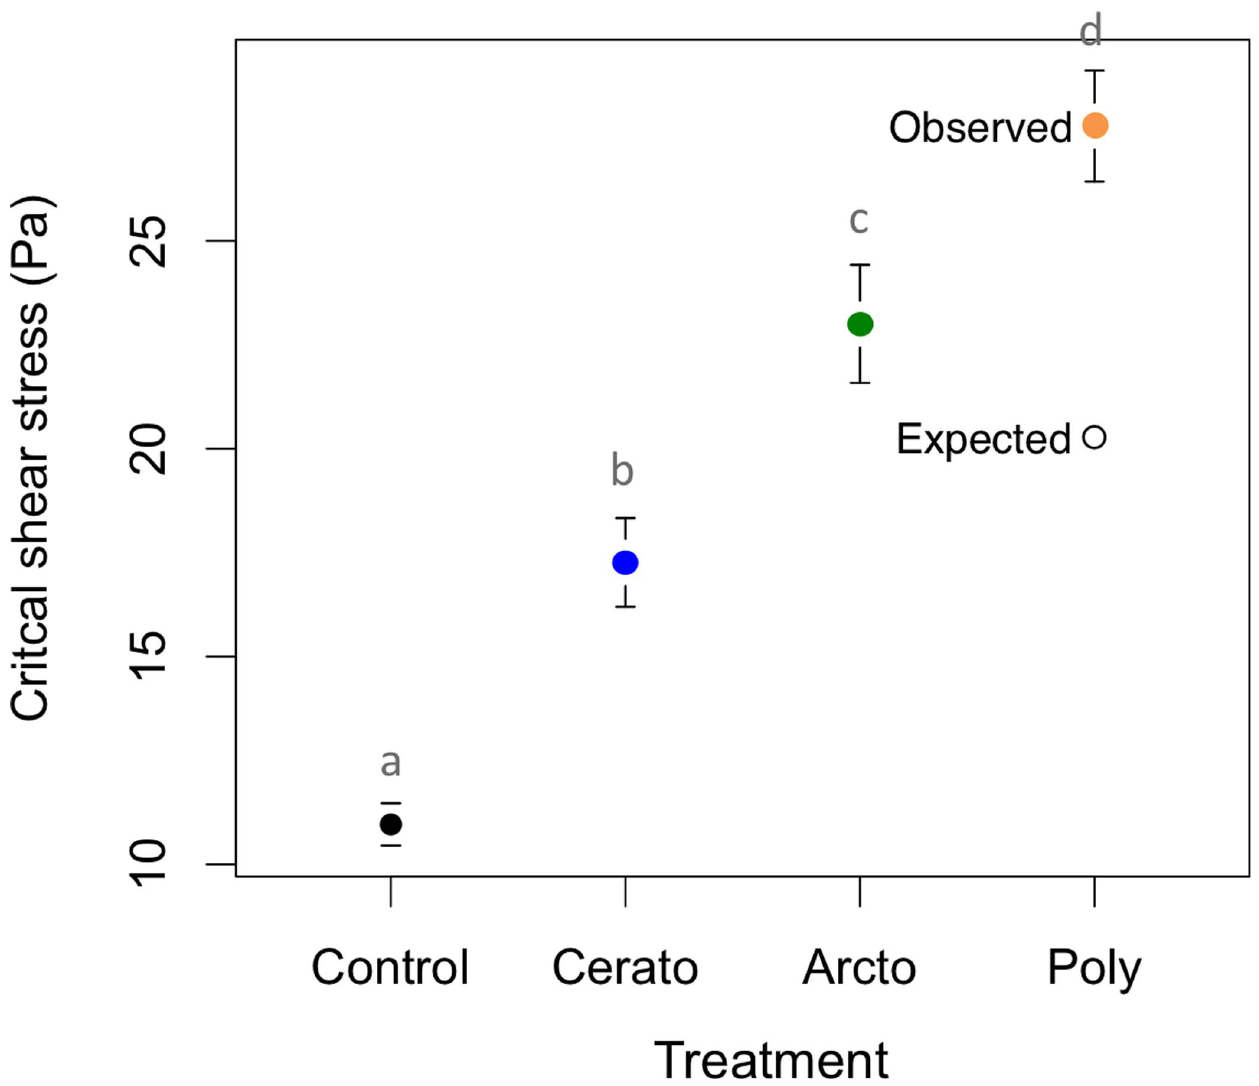
Figure 2. Impacts of monocultures and polycultures of caddisflies on critical shear stress. Values are means 6 1 SEM for N=8. Lowercase letters indicate significant differences between treatments.